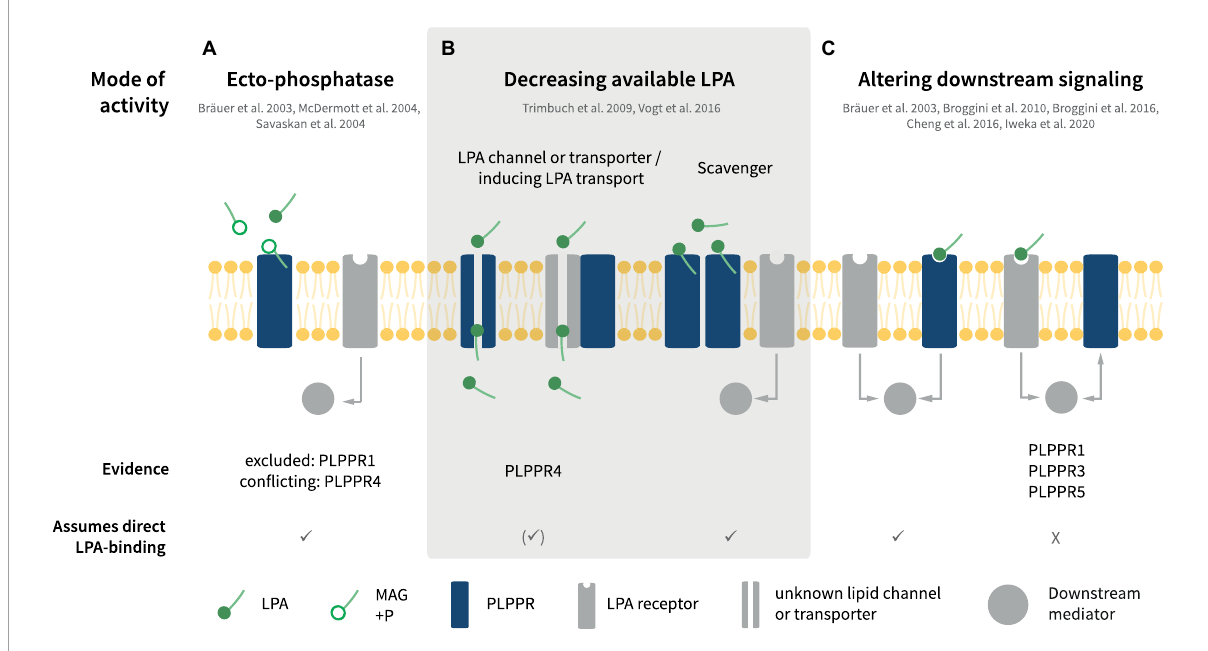
FIGURE4 Putative modes of PLPPR interaction with LPA signaling. (A) PLPPRs may inactivate LPA via ectophosphatase activity. (B) PLPPRs may limit extracellular LPA in a direct or indirect manner, functioning as transporters or scavengers or by influencing an unknown LPA transporter. (C) PLPPRs impinge on LPA intracellular signaling either directly or indirectly, by inducing or inhibiting LPAR-mediated downstream signaling. Note that several, but not all of the modes presented imply direct binding of LPA to PLPPRs. For details, please refer to